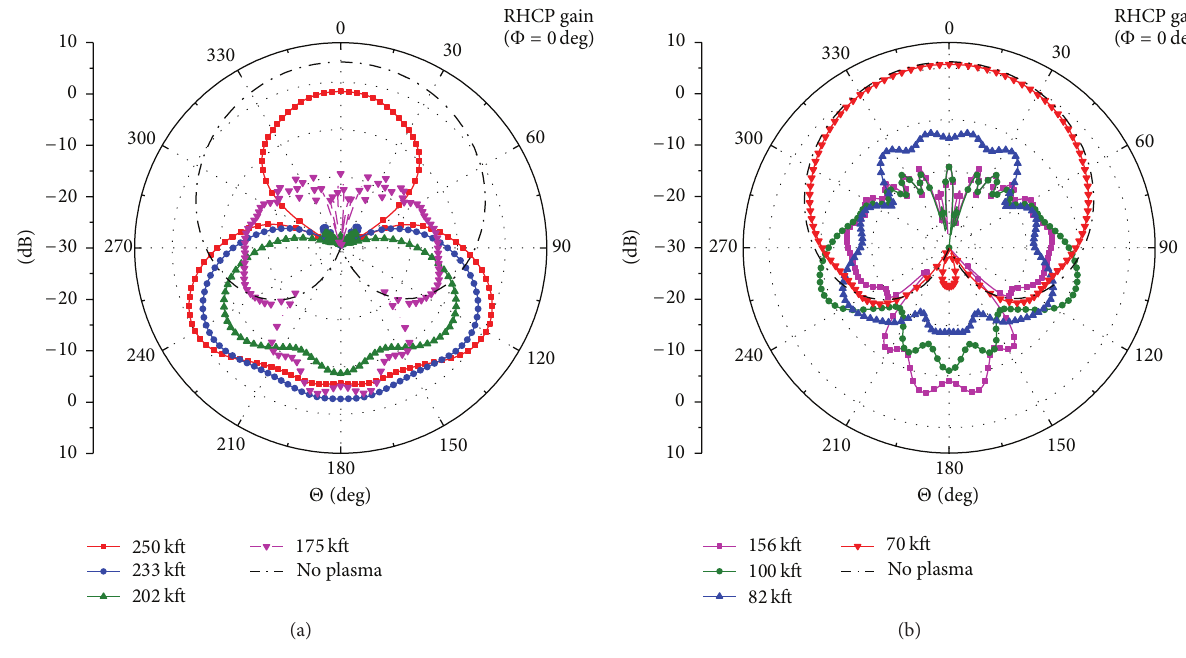
Figure 4: RHCP gain (plane of phi = 0deg) at different